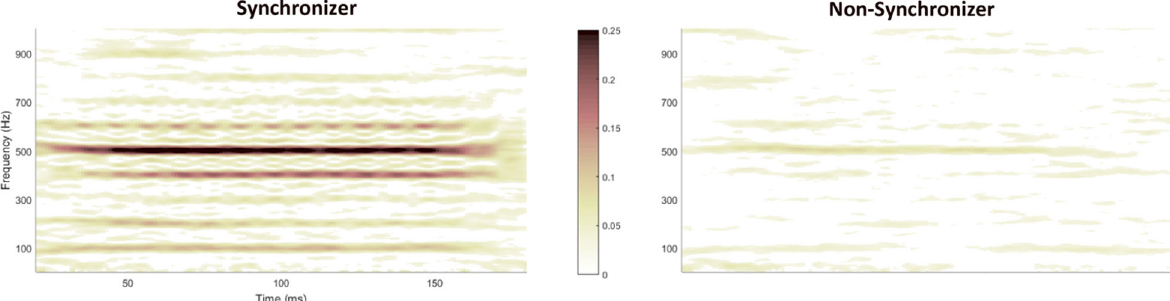
Fig. 5 Visual representation of the difference in phase-locking consistency between a representative Synchronizer (left) versus a representative Non-synchronizer (right). The responses shown were elicited from a [ba] stimulus, presented in a quiet condition. Darker colors depict higher phase-locking consistency. The PLF is calculated on overlapping 40-ms bins in the response and is illustrated on a colorscale, ranging from yellow (0, complete phase variability) to red (0.25, higher phase